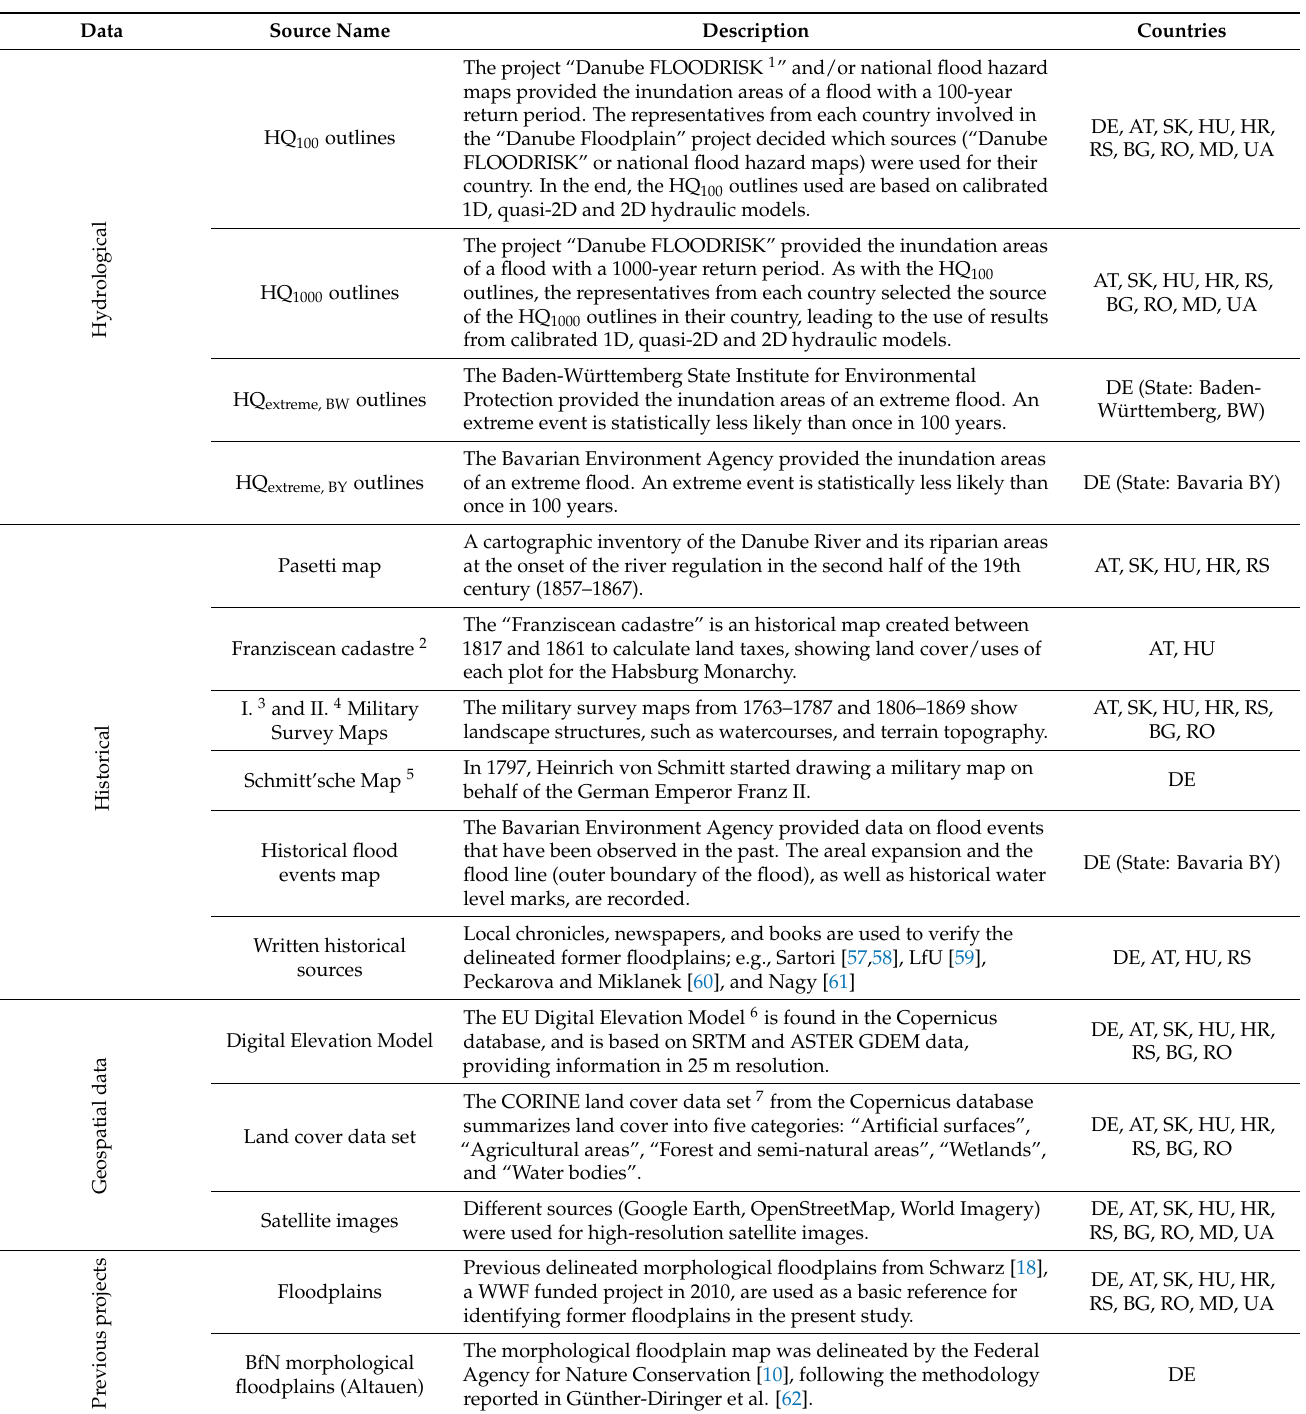
Table 1. Overview of all data sources used for identifying the active, former, and potential flood- plains along the Danube River. Country code: DE = Germany, BW = Baden-Württemberg, BY- Bavaria, AT = Austria, SK = Slovakia, HU = Hungary, HR = Croatia, RS = Serbia, BG = Bulgaria, RO =